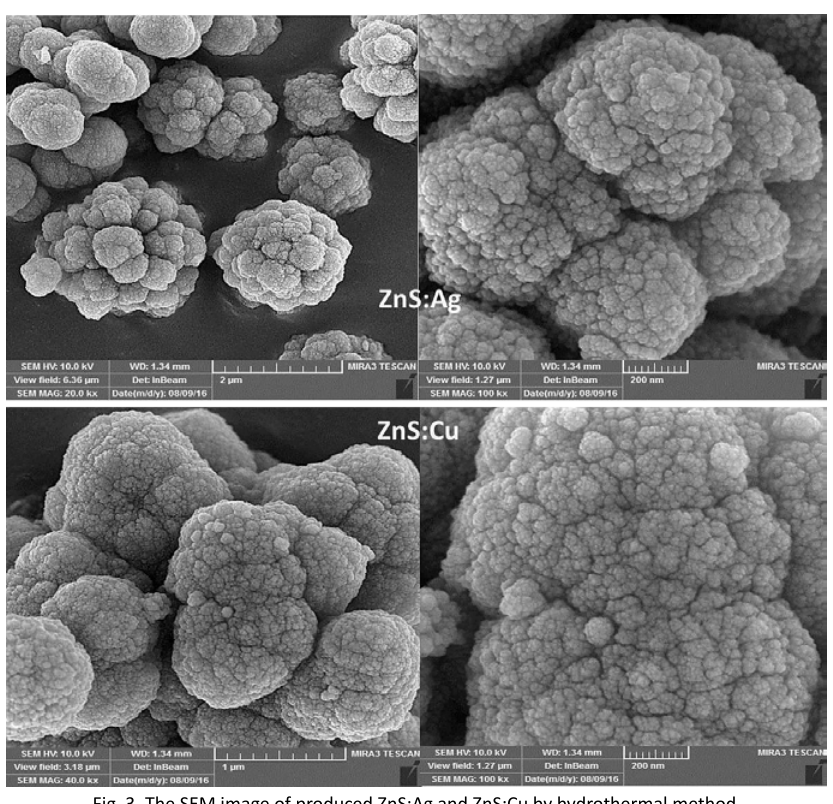
Fig. 3. The SEM image of produced ZnS:Ag and ZnS:Cu by hydrothermal method.